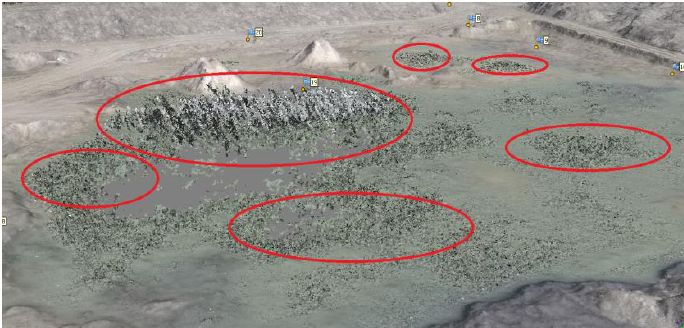
Figure 11. Errors on the point cloud created in areas flooded with water (marked in red ellipses).